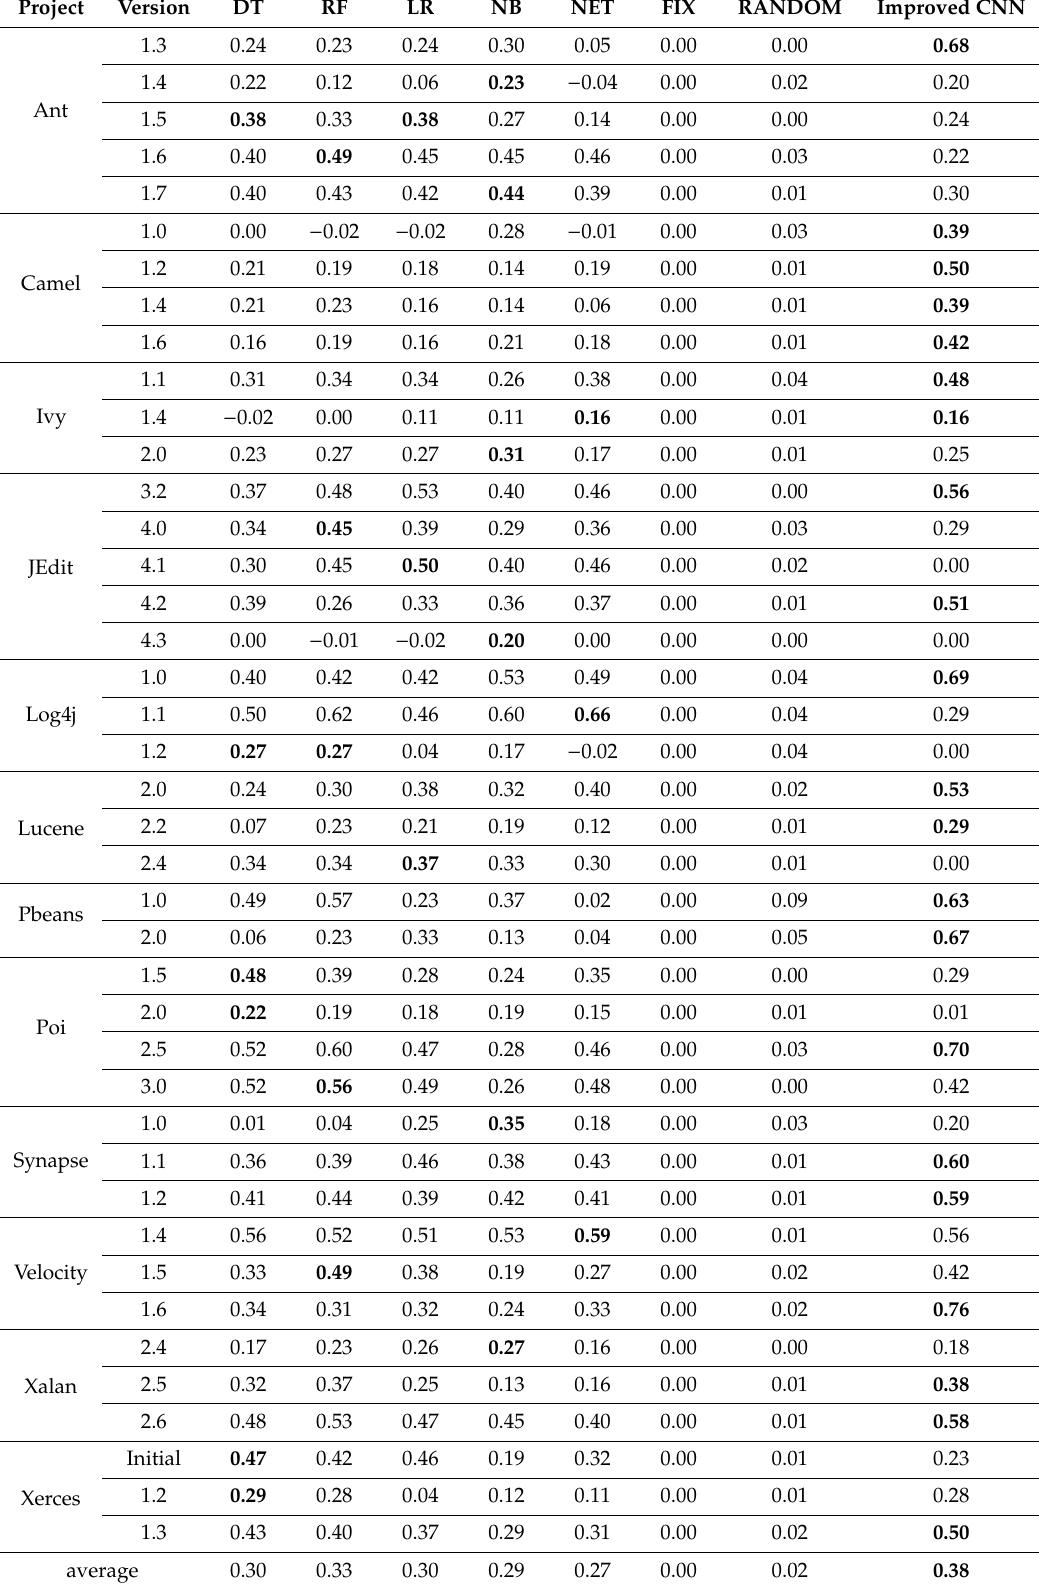
Table 8. Performance comparison of di ff erent models on the PSC dataset. The decimal values represent the average MCC measure values. The best MCC measures for each row are highlighted in